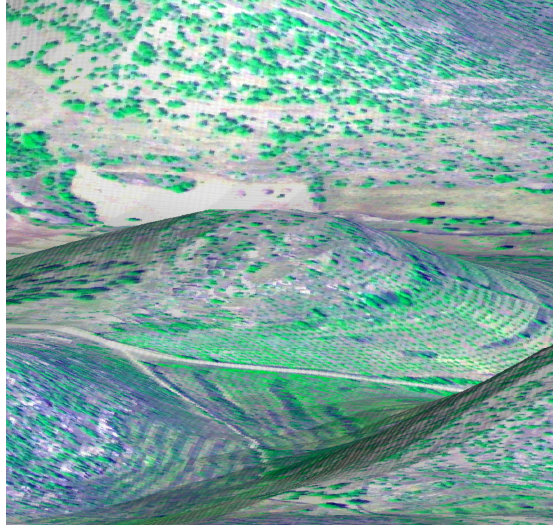
Fig. 8. Keferde, a landscape model view in 3D from SE. The dominance of the hill in the terrain is clearly visible. Technical information as in Fig. 3 above. Created by Markus